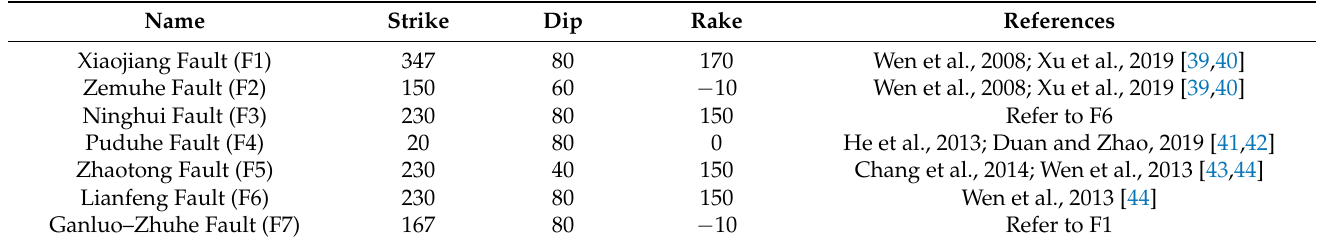
Table 1. Geometric parameters of main faults around Baihetan reservoir and the corresponding